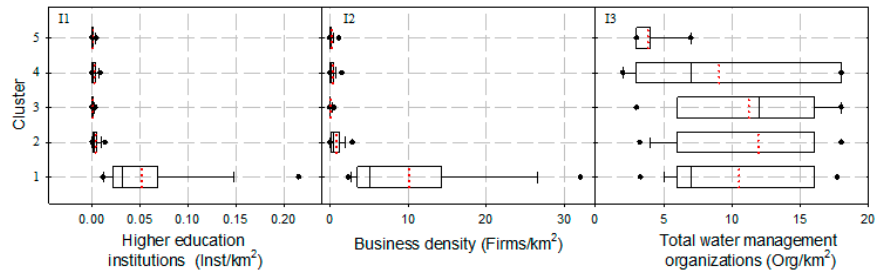
Figure 9. Regional institutional characteristics with real values. Average value is the dotted red line.